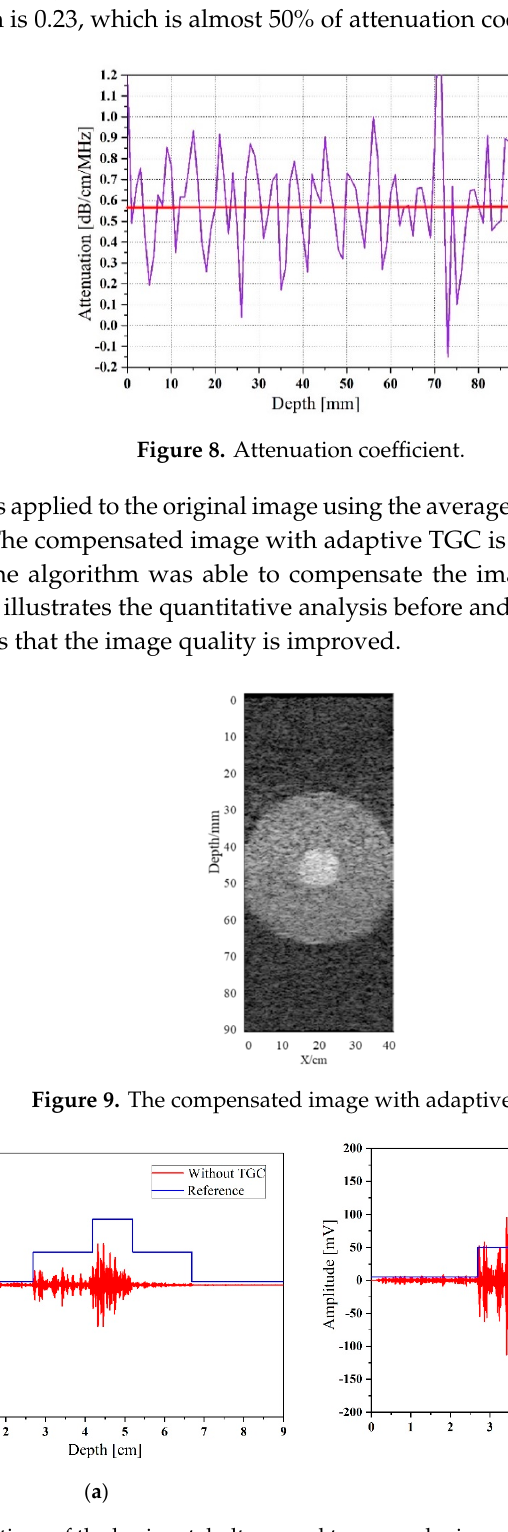
Figure 10. Cross-sections of the horizontal ultrasound tomography image at y = 9 cm: ( a ) without TGC, ( b ) with adaptive TGC.